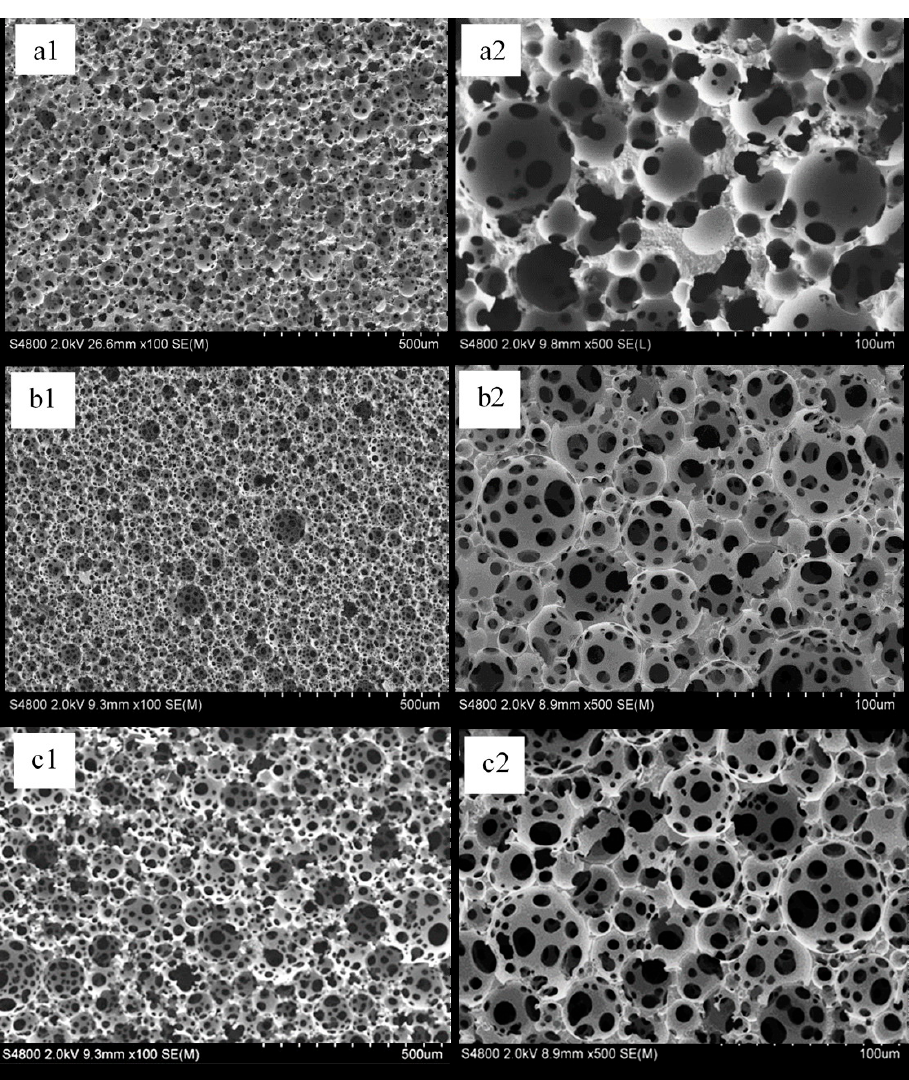
Figure 3. SEM micrographs (100× and 500× magnification) of poly(TT/DPEHA)HIPEs at 3-wt% Hypermer B246 with different percentages of aqueous phase. ( a1 , a2 ) 80 vol%: ( b1 , b2 ) 90 vol%; ( c1 , c2 ) 92 vol%.